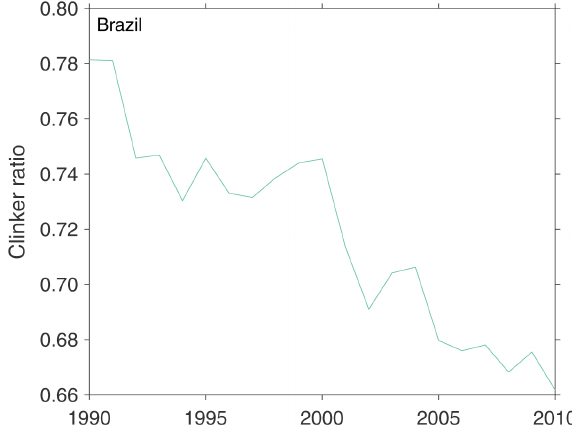
Figure C14. Brazil’s approximate clinker ratio, with no account for clinker trade.